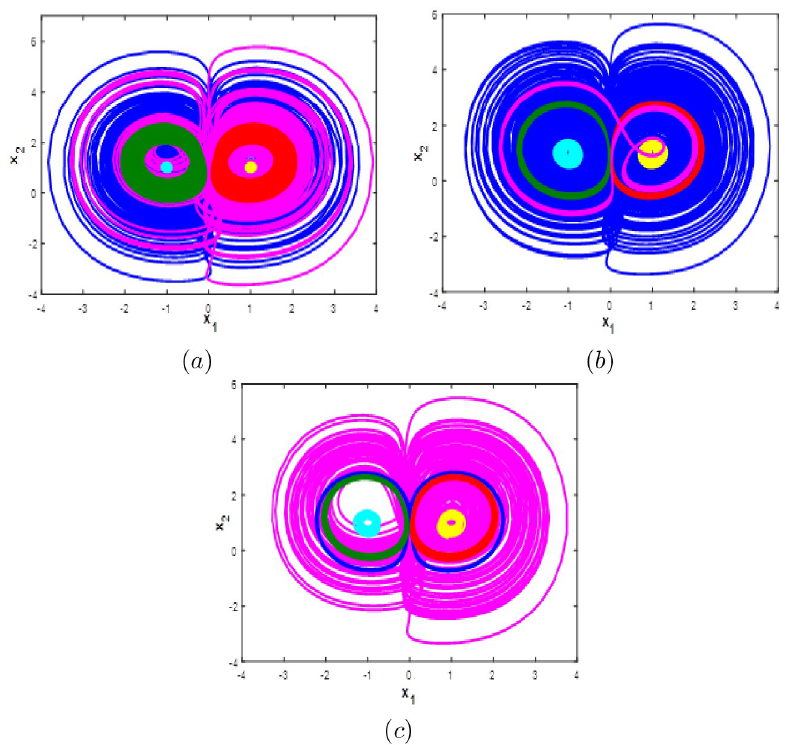
Fig 16. Coexistence of six different attractors projected on the x 1 − x 2 plane. (a) Coexistence of two chaotic attractor and four quasi-periodic attractors when c = 0.3. (b) Coexistence of one hyperchaotic attractor starting from ξ 1 (blue) and five quasi-periodic attractors when c = 0.85. (c) Coexistence of one chaotic attractor starting from ξ 4 (magenta), one periodic attractor (blue) and four quasi-periodic attractors when c = 2.9.